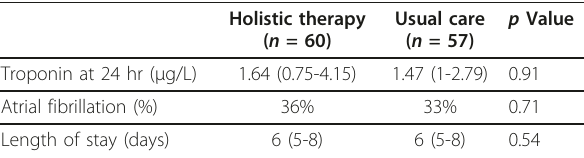
Table 2 Clinical endpoints